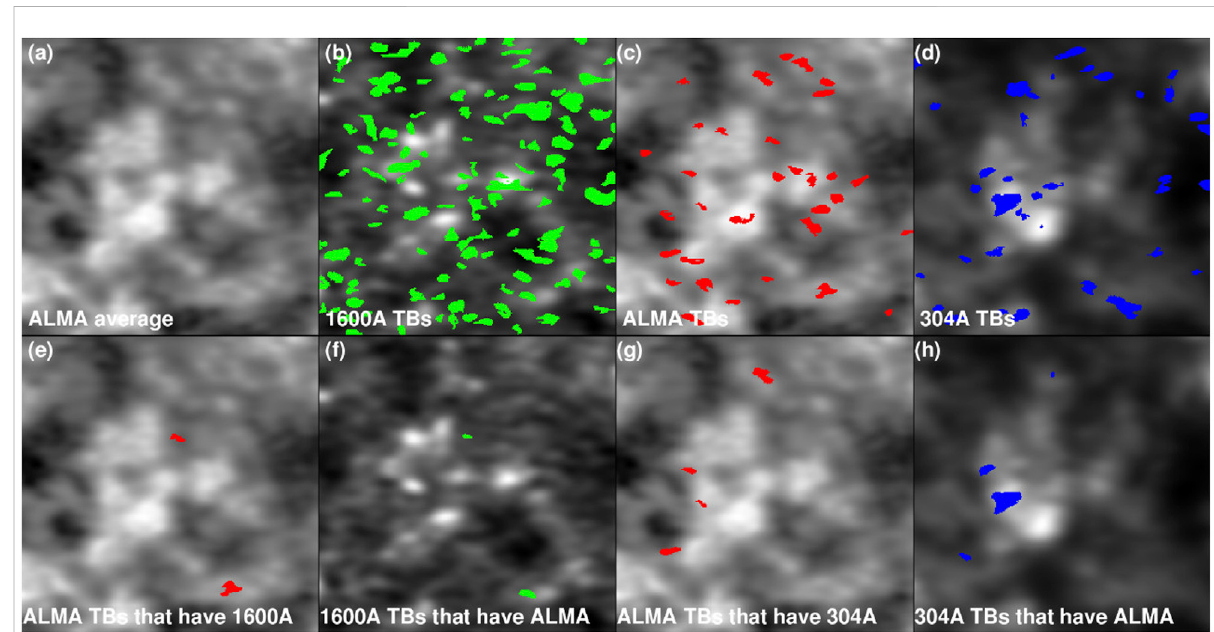
FIGURE 6 The different colors mark the pixels participating in transient brighteningsin 1600 Å (green), 3 mm (red) and 304 Å (blue) 10-min data of a quiet Sunregion.Inpanels (A – D) alleventsidenti fi edatagivenwavelengtharedisplayed.Inthebottomrow,panels (E , F) displaytheeventsappearingboth at3 mmand1600 Åwhilepanels (G , H) displaytheeventsappearingbothat3 mmand304 Å(fromNindosetal.,2020).Reproducedwithpermission ©